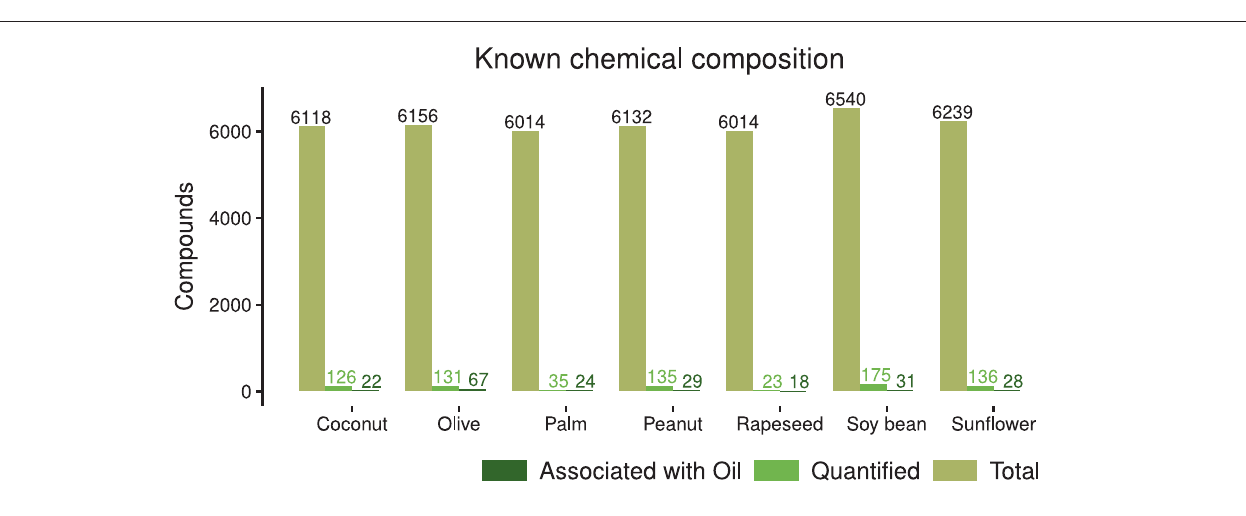
FIGURE 3 | The number of chemical compounds associated with each source of vegetable oil in FooDB as of April 2020. From the total number of chemicals associated with each crop, the large majority are “expected [to be present] but not quantified”. The others can be associated with the ingredient in its raw form or in its oil. Most quantified compounds are associated with the raw product, and only a tiny fraction is explicitly associated with the oil. Note that for palm and rapeseed the amount of chemicals associated with the oil is almost the same as the quantified fraction, likely because these products are mostly consumed in their oil